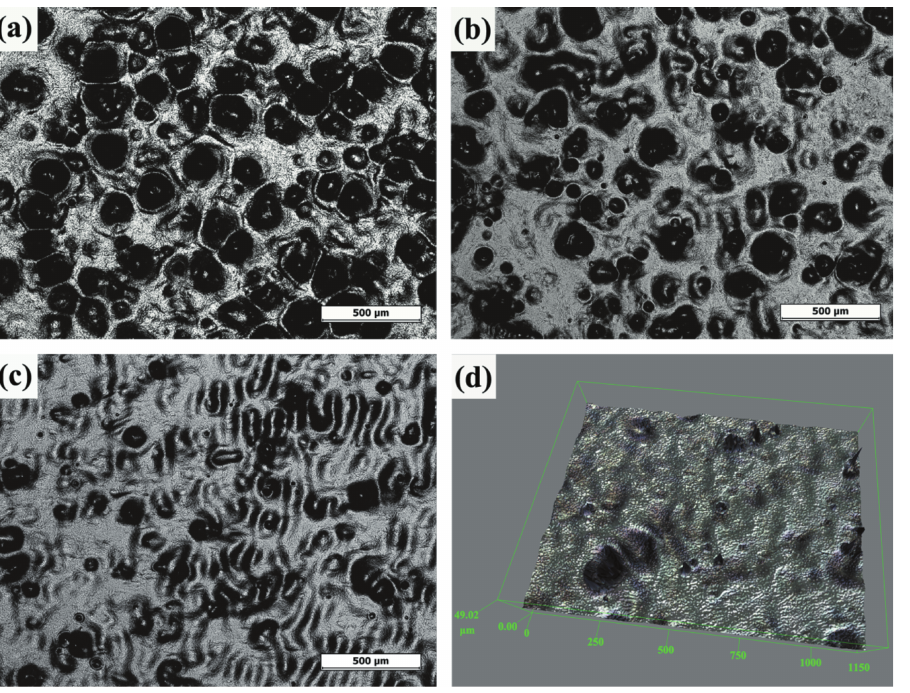
Figure 1: Typical surface micro- graphs of HCPEB-treated 3Cr13 stainless steel samples: (a) OM, 5 pulses, (b) OM, 10 pulses, (c) OM, 20 pulses, (d) laser three- dimensional image, 20